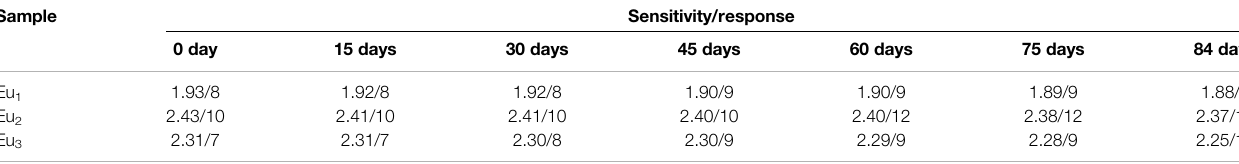
TABLE 2 | Sensing parameters upon different aging